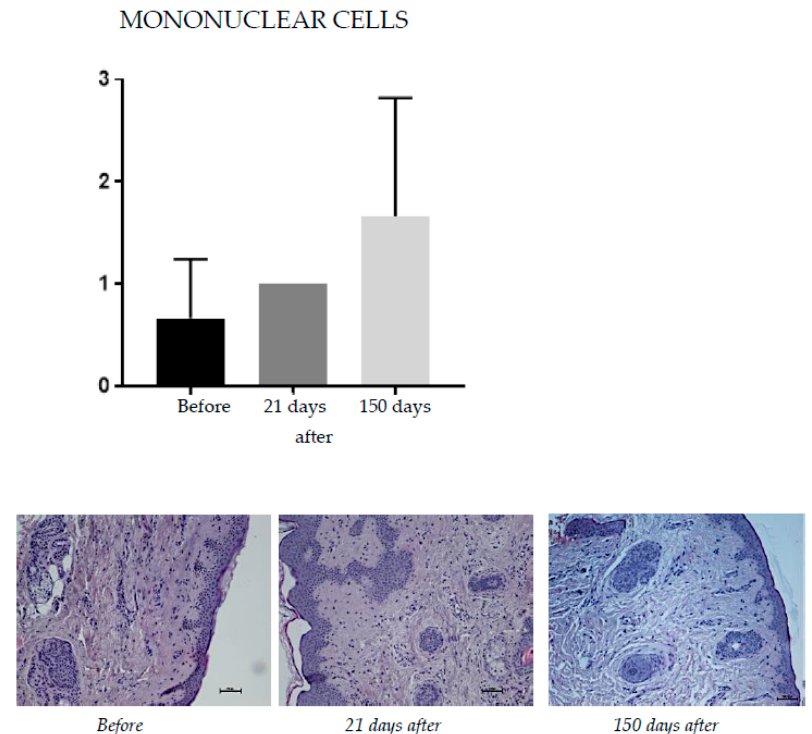
Figure 1. Patient, 61 years old. Hematoxylin and eosin staining, from left to right: before treatment; 21 days after treatment; 150 days after treatment. 2.1.2. CD68 (Monocytes and Macrophages) Protein expression was rated on a scale of 0–100% of inflammatory infiltrate cells (Figure 2).